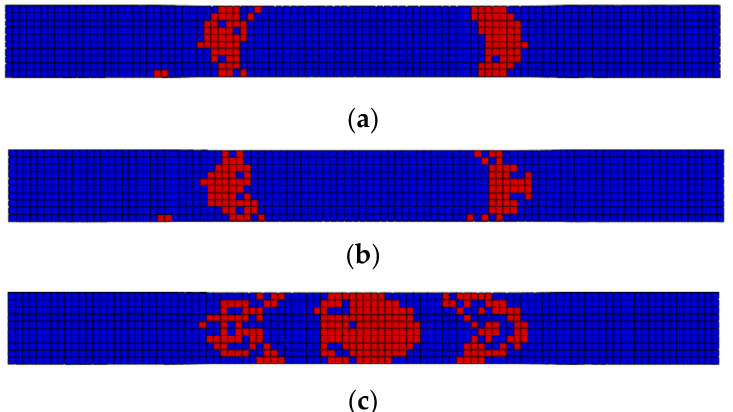
Figure 8. The final fatigue failure morphology calculated by the finite element method. ( a ) RTD; ( b ) CTD; ( c ) ETW.